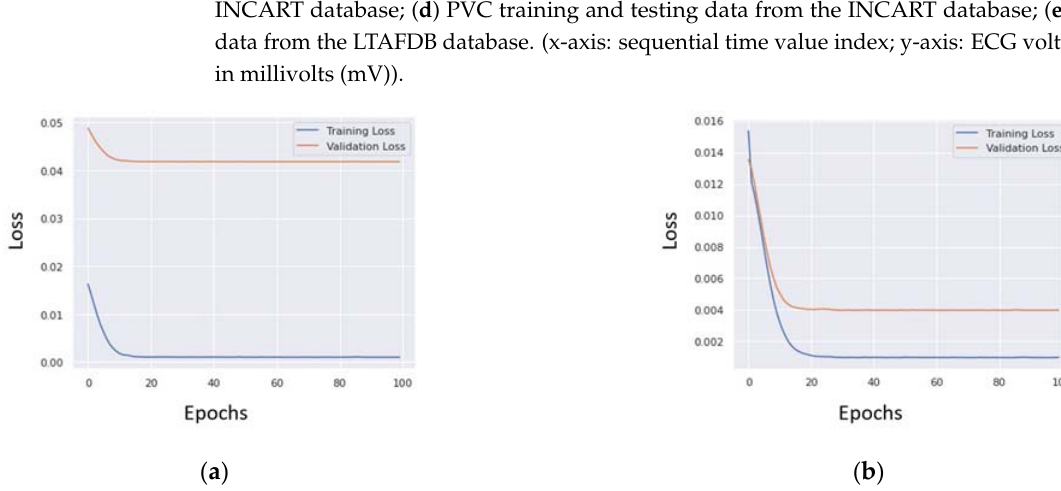
Figure 7. Training and validation loss for ( a ) NSR autoencoder; ( b ) PVC autoencoder. (x ‐ axis: training epochs; y ‐ axis: training/validation loss value).